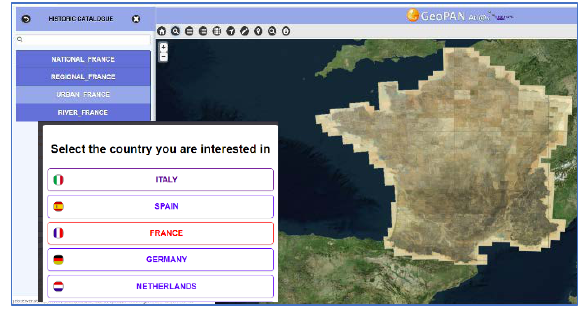
Figure 4. The GEOPAN APP search function and the crawled maps in